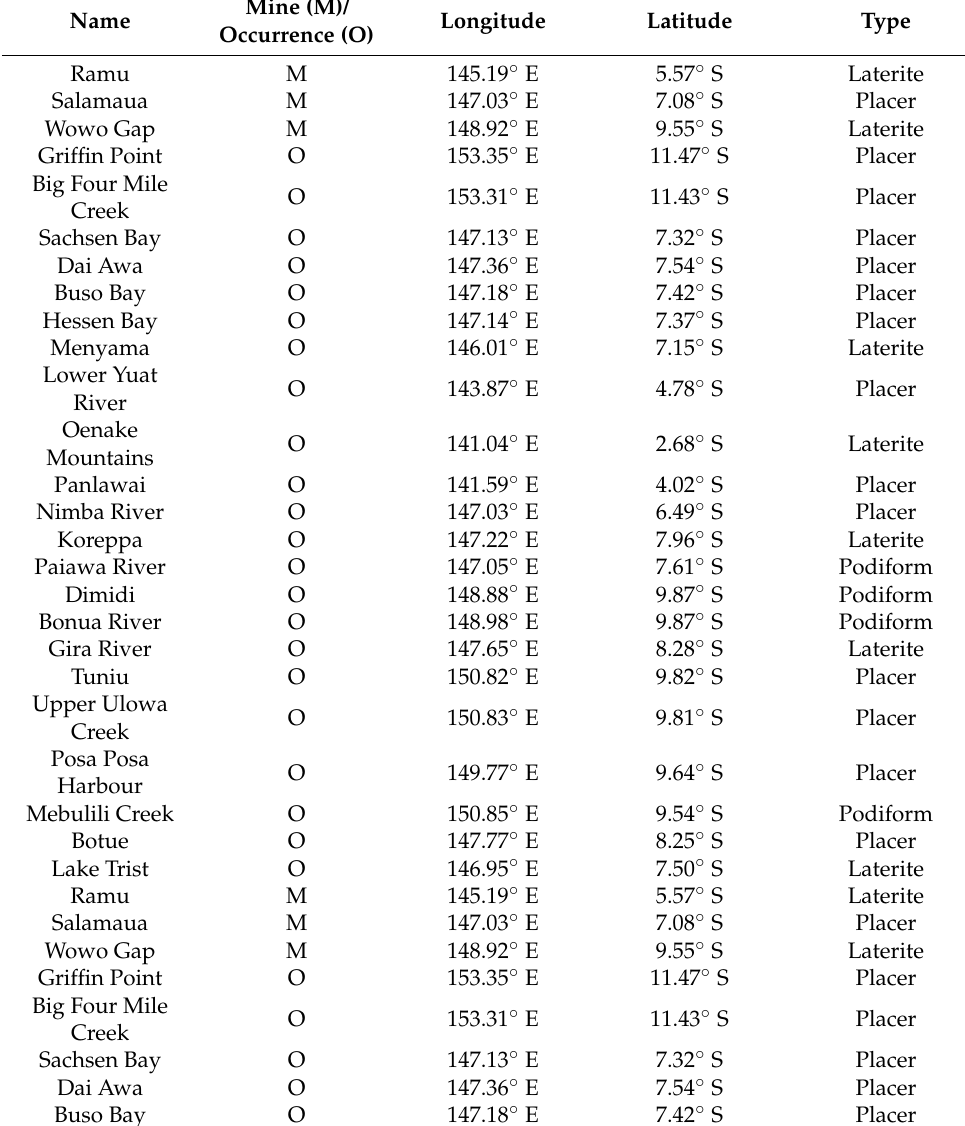
Table 1. Basic information of chromium-bearing mines and chromium occurrence in PNG